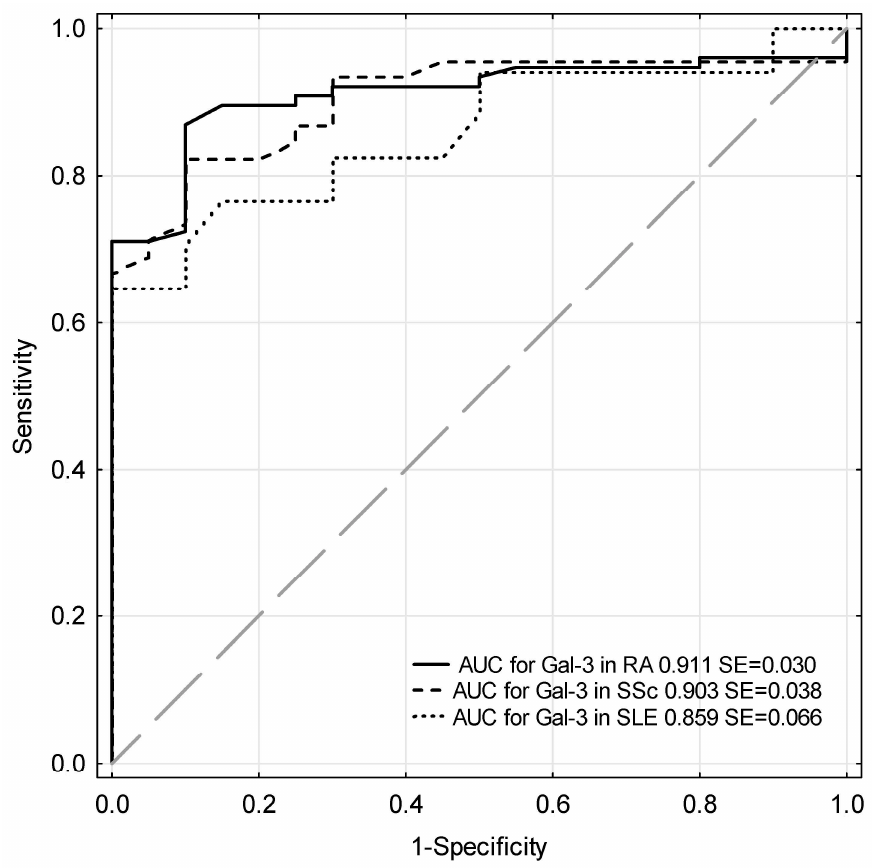
Figure 2. ROC curves for serum galectin-3 in rheumatic diseases.